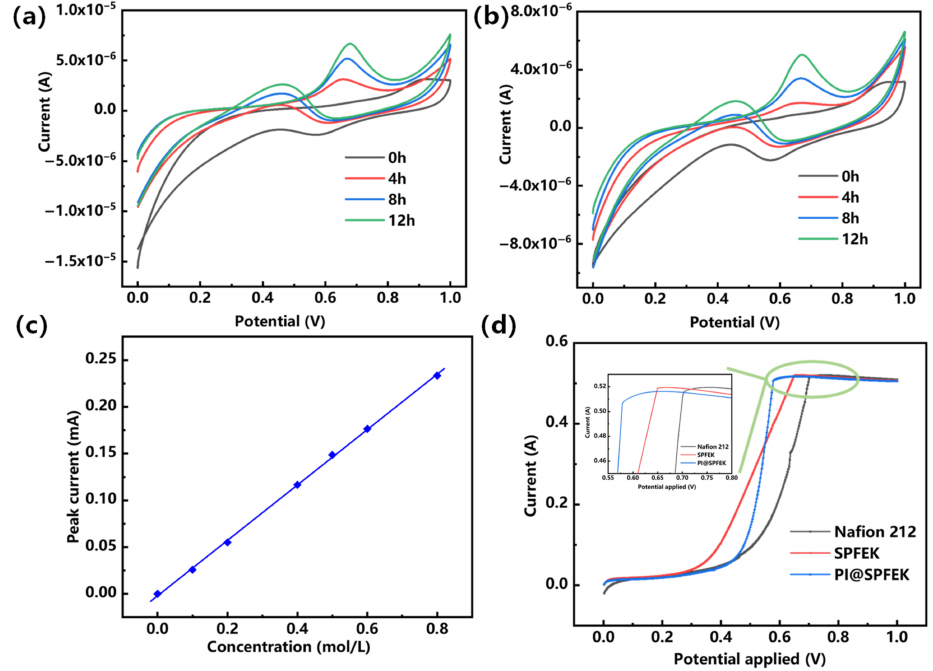
Figure 7. Cyclic voltammograms curves of ( a ) SPFEK and ( b ) PI@SPFEK membranes at room temperature over different diffusion times; ( c ) Calibration curve of the methanol solution; ( d ) The linear sweep voltammetry (LSV) curves of membranes for methanol crossover